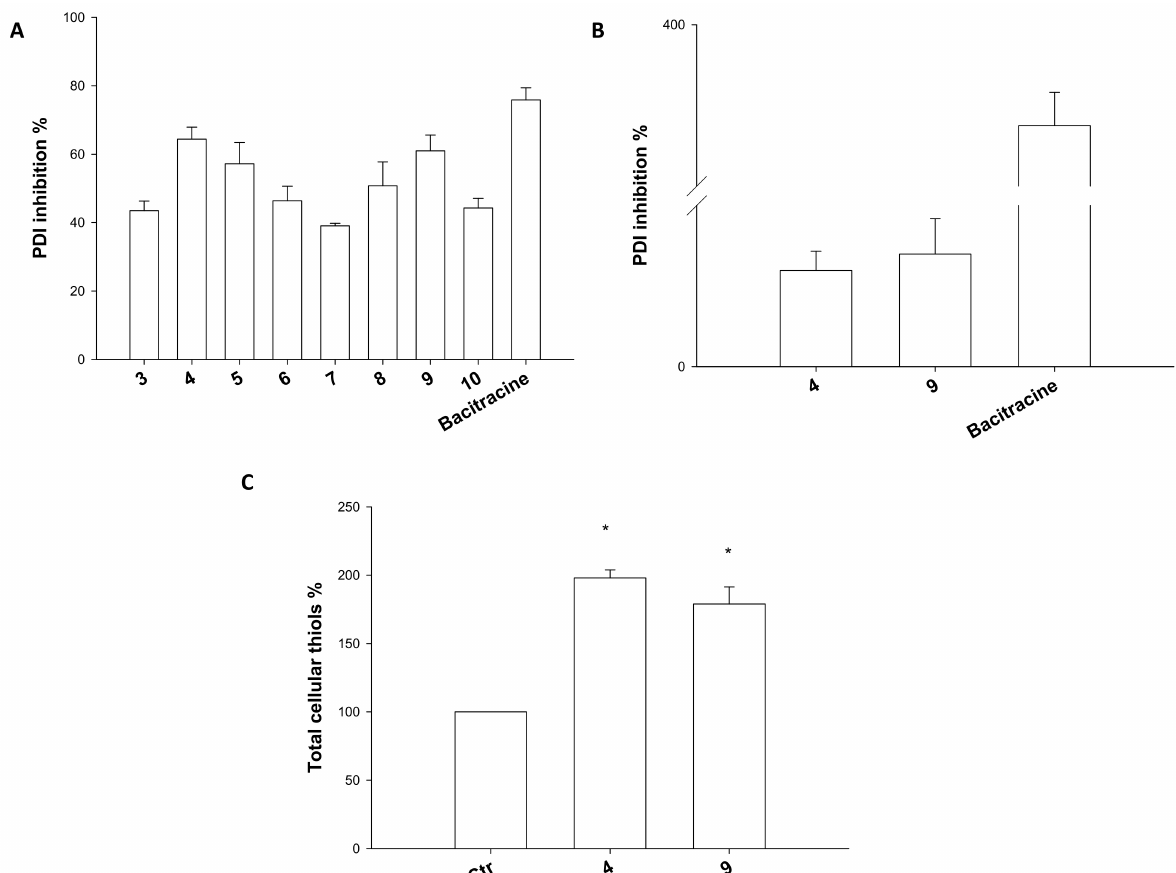
Figure 9. Mechanistic studies: PDI inhibition ( A , B ) and sulfhydryl content ( C ). ( A , B ) PDI inhibition induced by compounds 3 – 10 was measured by Proteostat PDI assay kit. The PDI inhibitor bacitracin (0.5 mM) was used as a positive control. In ( B ), the IC 50 values were calculated by 4-PL model. ( C ) Sulfhydryl content in HCT15 cancer cells incubated for 36 h with IC 50 of compounds 4 and 9 . The sulfhydryl group amount was determined by the DTNB assay. Error bars indicate S.D. * p < 0.05 compared with